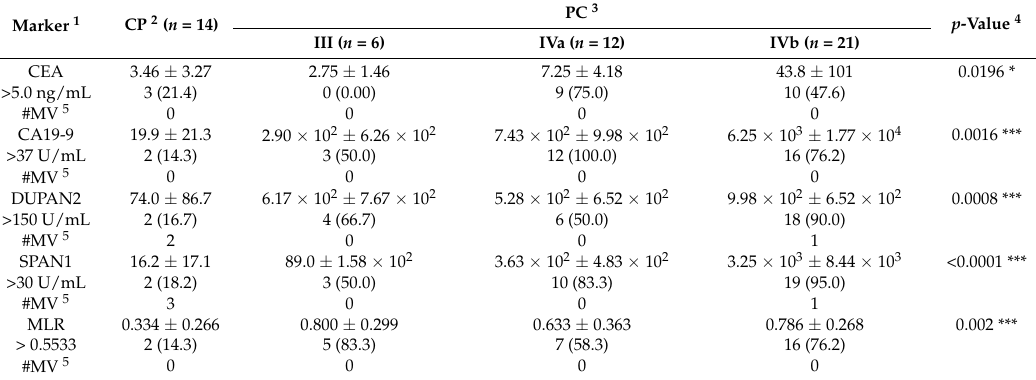
Table 3. The number of positive subjects of tumor markers and the MLR